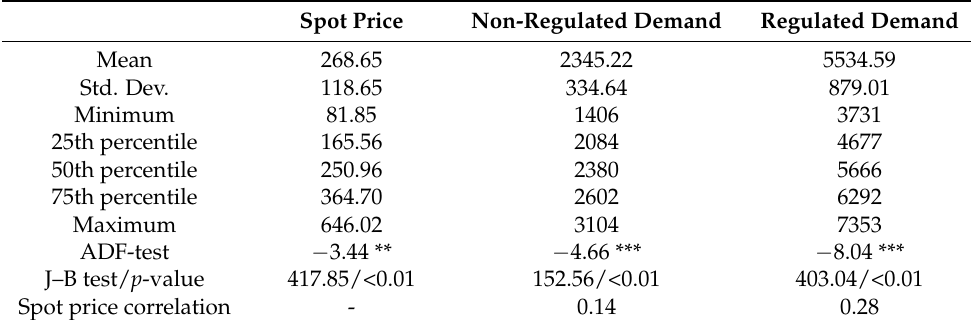
Table 2. Descriptive statistics of the variables for the 2020 period.